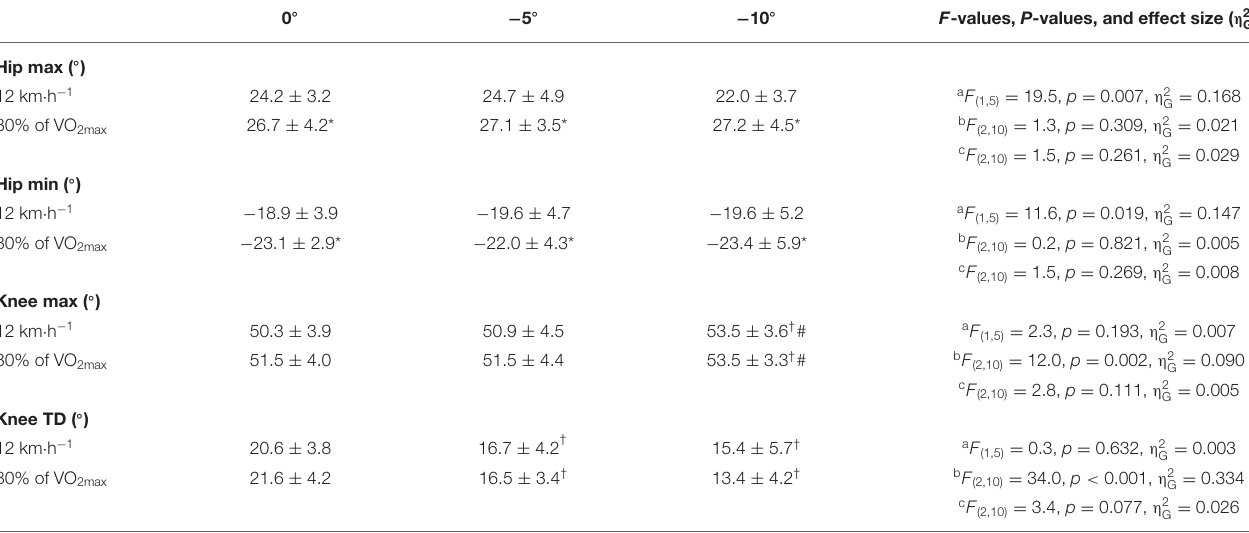
TABLE 2 | Hip and knee angles on level and downhill running ( n =